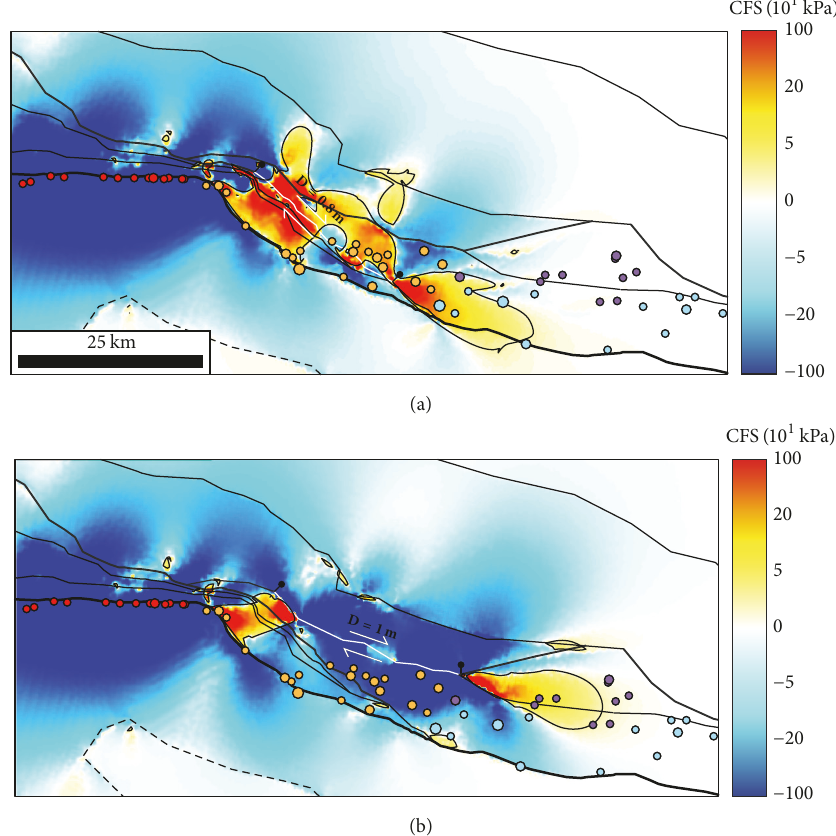
Figure 5: Coulomb static stress change best fit for doublet models 2.a and 3.a. (a) Modelling of doublet failure along the Lapause Fault. (b) Modelling of doublet failure along the Rivi`ere-H´eva Fault using regional geological and structural framework. Positive lobe boundaries are set at 30 kPa. The circles indicate deposits’ locations, with colours reflecting the distinct goldfields as explained in Figure 1.